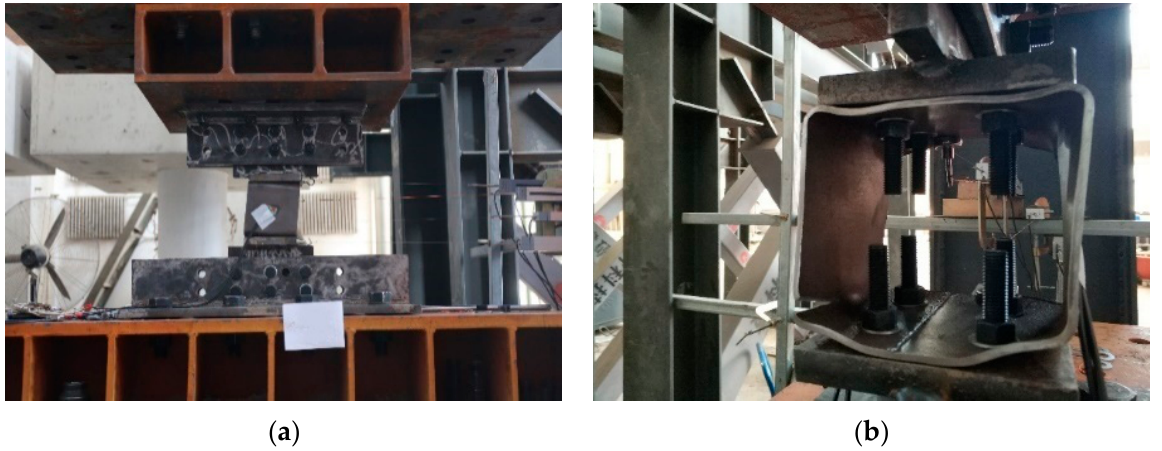
Figure 8. Failure modes of the bolted steel tube dampers: ( a ) corner of 150 ‐ D1 warping; ( b ) steel tube end of 150 ‐ D1 tearing.